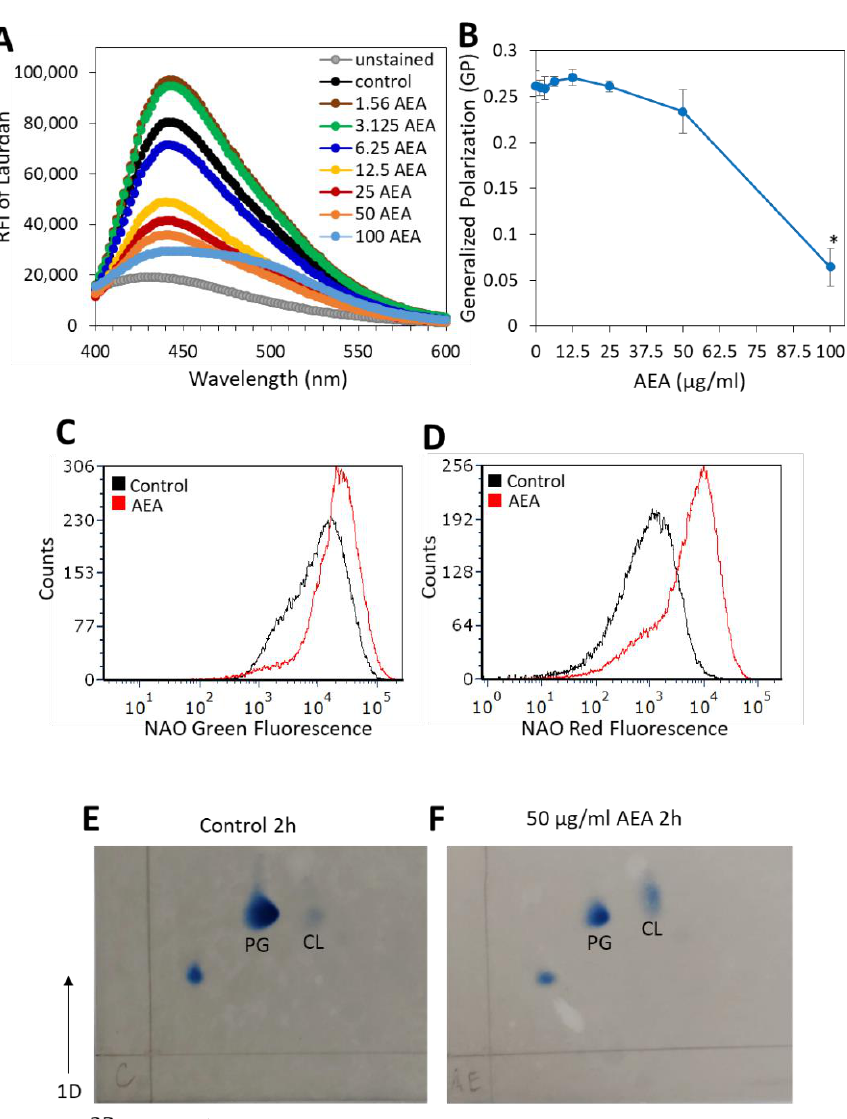
Figure 7. AEA treatment prevents the incorporation of Laurdan into the bacterial membrane and increases the relative cardiolipin content. ( A ). MDRSA CI-M was treated with various concentrations of AEA for 5 h and then loaded with 10 µM Laurdan for 10 min at 37 °C, followed by extensive washes in PBS, and the relative emission fluorescence intensities (RFIs) were measured from 400–600 nm upon excitation at 350 nm. ( B ). Generalized Polarization (GR) values of samples in ( A ), calculated according to the formula: GP = (RFI 440nm − RFI 490nm )/(RFI 440nm + RFI 490nm ). * p < 0.05 when comparing the AEA-treated bacteria with control bacteria. ( C , D ). MDRSA CI-M was treated with 12.5 μg/mL of AEA for 2 h at 37 °C and then stained with 10-N-nonyl-acridine orange (NAO) for 30 min at 37 °C, followed by flow cytometry measuring the green (total dye uptake) ( C ) and red fluorescence (dye bound to cardiolipin) ( D ). ( E , F ). Thin-layer chromatography (TLC) of membrane lipids isolated from control ( E ) and AEA (50 μg/mL, 2 h)-treated MDRSA CI-M ( F ). PG = Phosphatidylglycerol; CL = Cardiolipin.